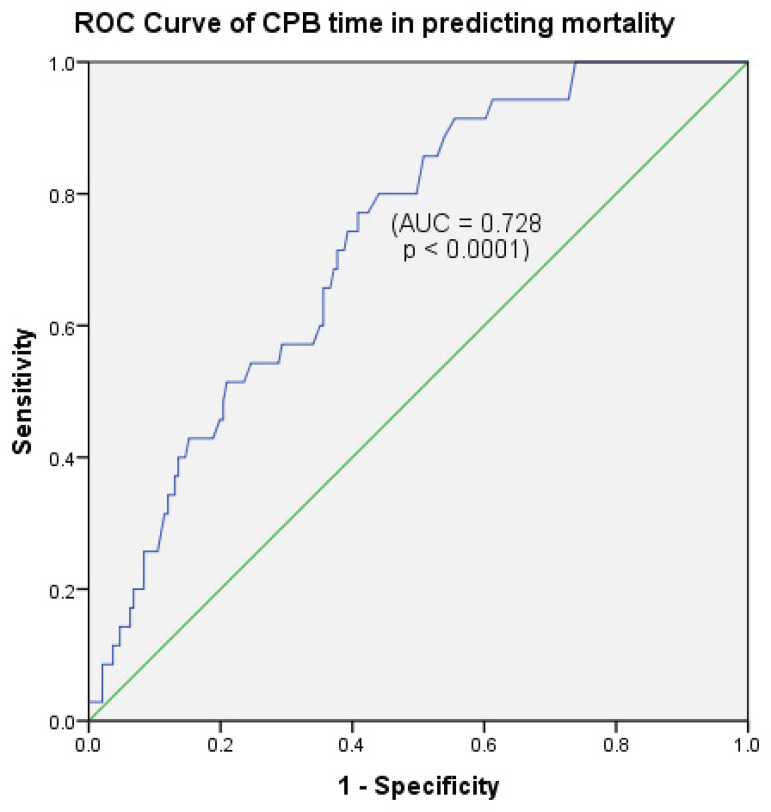
Cutoff point of 223 minutes (3.72 hours) had an accuracy of 72.8% in predicting mortality (sensitivity 73.5%, specificity 60.1%, P<0.0001).AUC=area under the curve; CPB=cardiopulmonary bypass; ROC=receiver operating characteristics